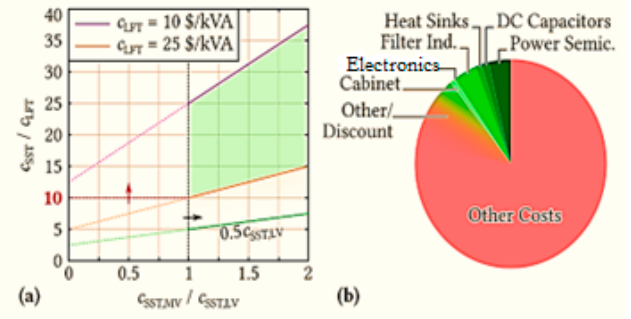
Figure 16. ( a ) Cost analysis of a 1000 kVA AC–AC SST which is at least 5 to 10 times that of a similarly rated LFT, ( b ) a comparison of a 500 kVA LV inverter’s projected material costs with list price information from [15,75]. Reprinted with permission from Ref. [15]. 2022, IEEE.